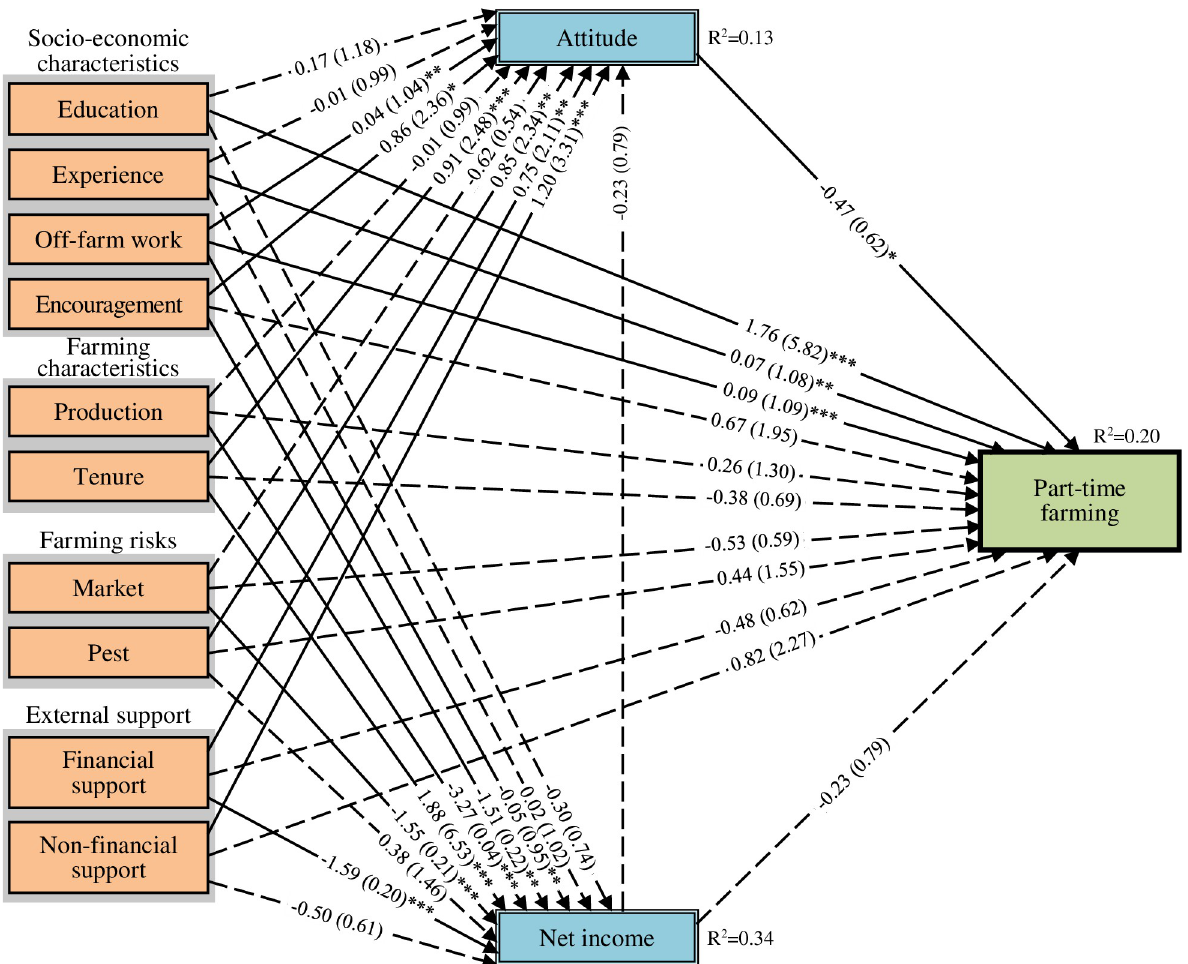
Fig 8. Path diagram of result of generalised structural equation modelling for part-time farming. Notes: 1) number of part-time farmers = 43, 2) number of samples (n) = 176, 3) � , �� , ��� significant at 10%, 5%, and 1% levels, 4) Dashed lines represent statistically insignificant path coefficients, 5) Numbers in the brackets were odds ratios, and 6) Second-order bias-corrected Akaike information criterion (AICc) = 873.86.